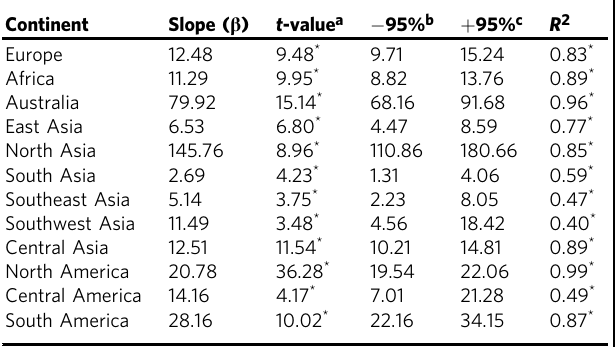
Table 2 Regression between carbon gap fl ux and population